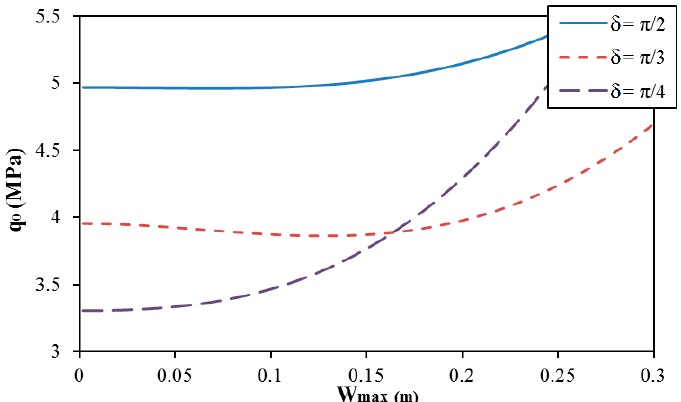
Figure 4. Effect of the corrugation radius r on the postbuckling curve of round spiral corrugated sandwich FGM cylindrical shells ( K 1 = 10 7 N / m 3 , K 2 = 5 × 10 4 N / m, N = 1, d = 0, and k = 1).